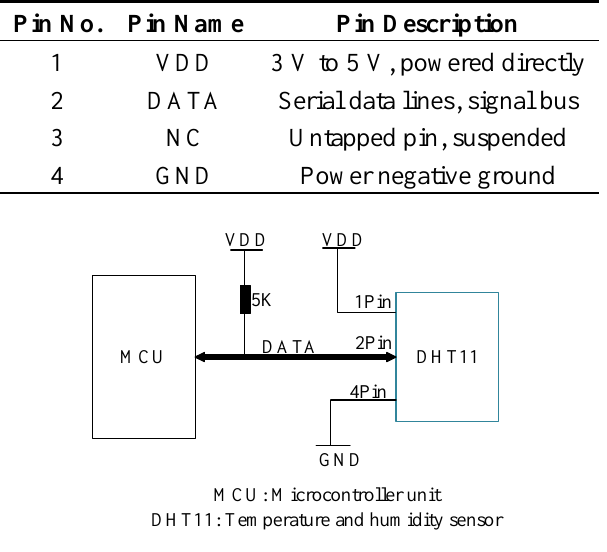
Figure 5. Application circuit of the temperature and humidity sensor.